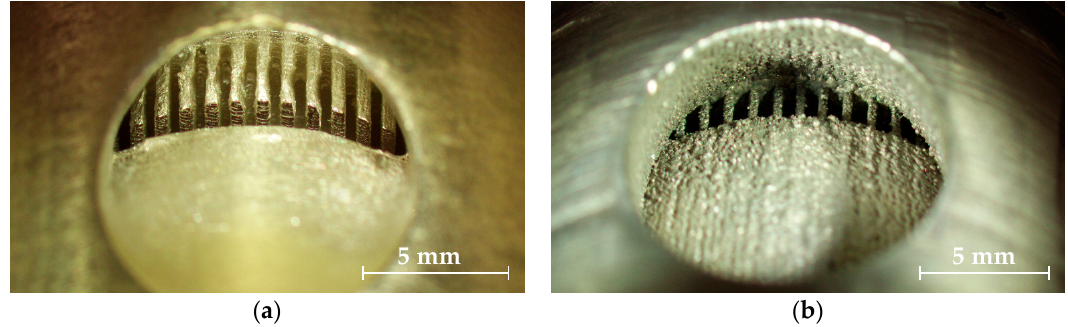
Figure 4. Internal structure of the water cooling cavity. ( a ) SS925 solid target holder; ( b ) A357 solid target holder.